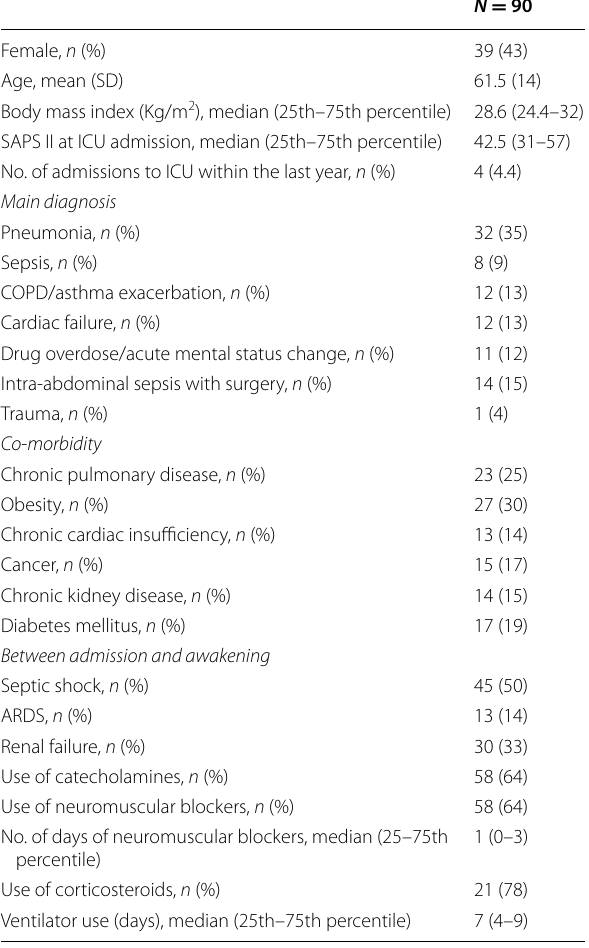
Table 1 Cohort characteristics